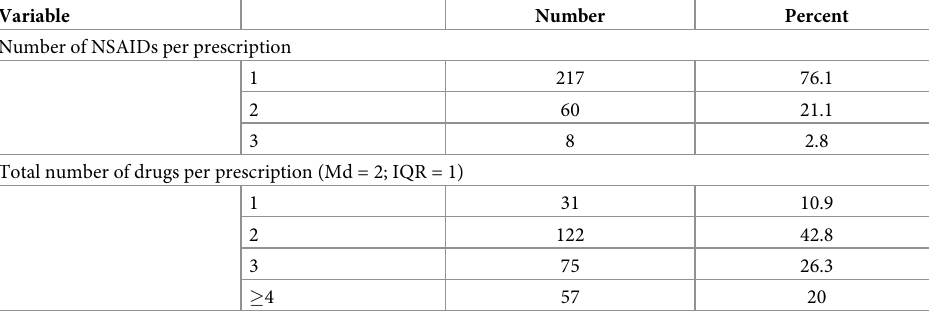
Table 2. Pattern of NSAIDs prescription among the elderly (N = 285).